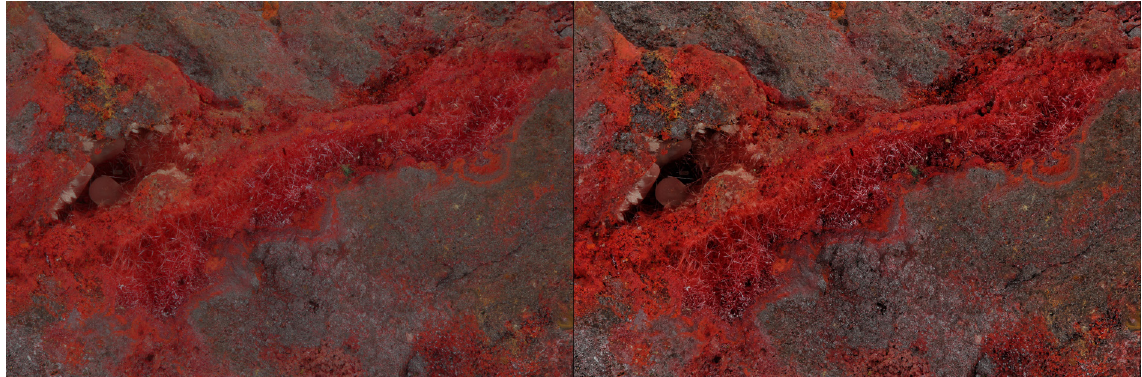
Fig. 5.4. Micro-contrast enhancement in DxO OpticsPro 11. The original image is on the left, the post- processed picture on the right. The post-processed picture looks more crisp and shows more details than the original one as the washed-out appearance has gone.